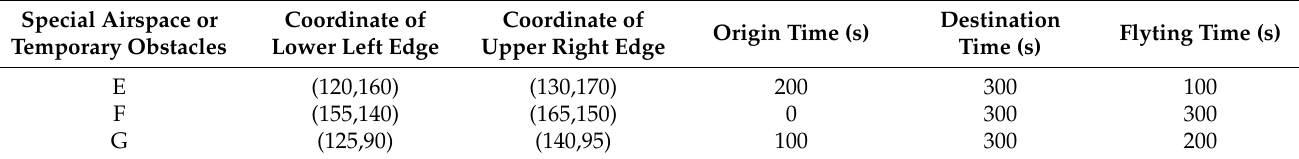
Table 2. Time and location of the appearance of special airspace or temporary